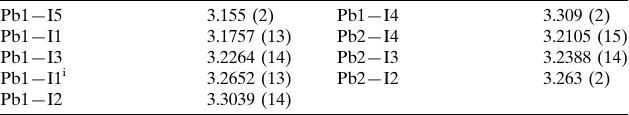
Selected geometric parameters (A˚ , (cid:4) ).